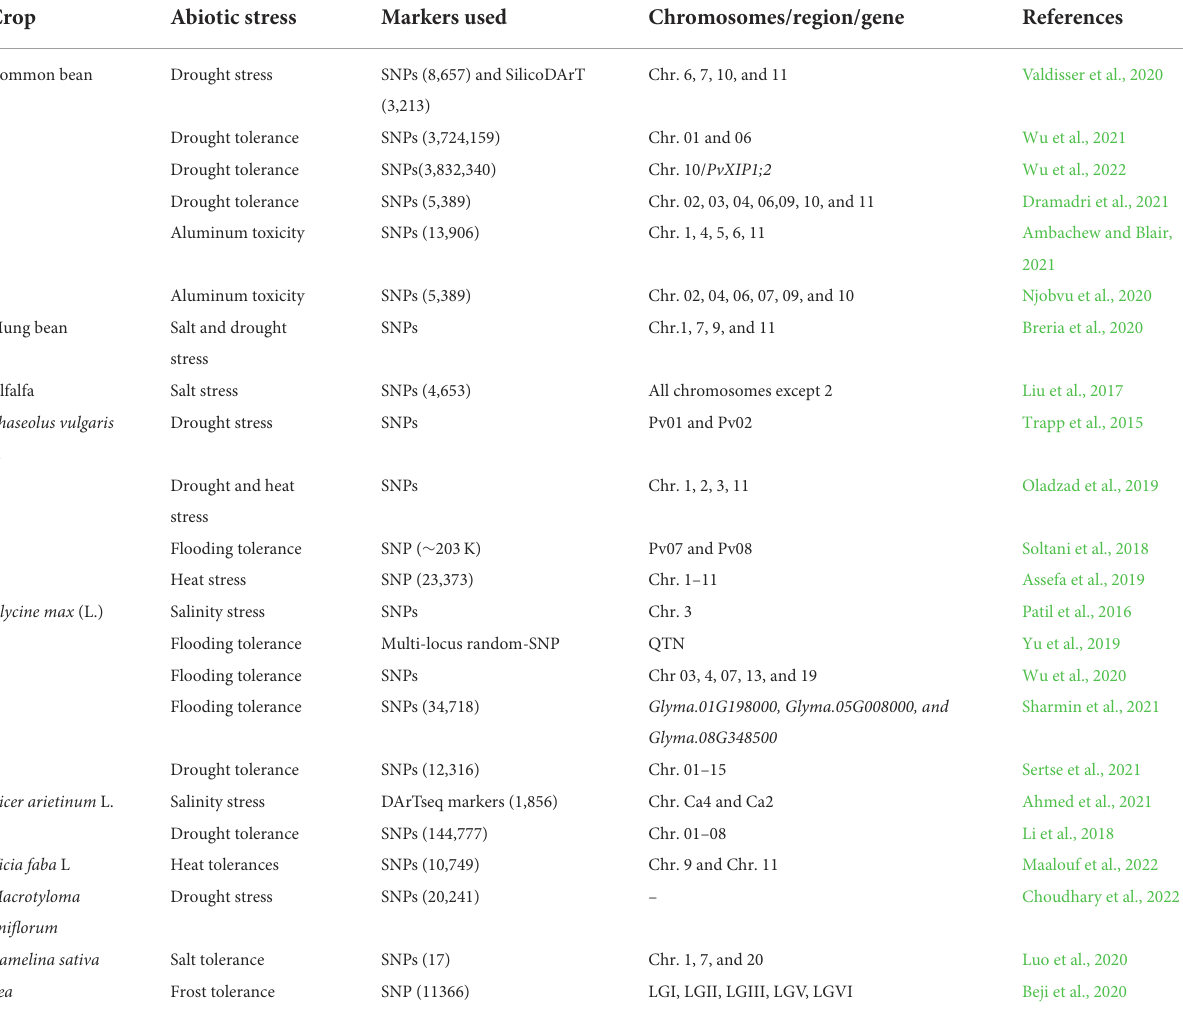
TABLE 5 Application of GWAS approach to identify the genomic regions associated with abiotic stresses in legumes.